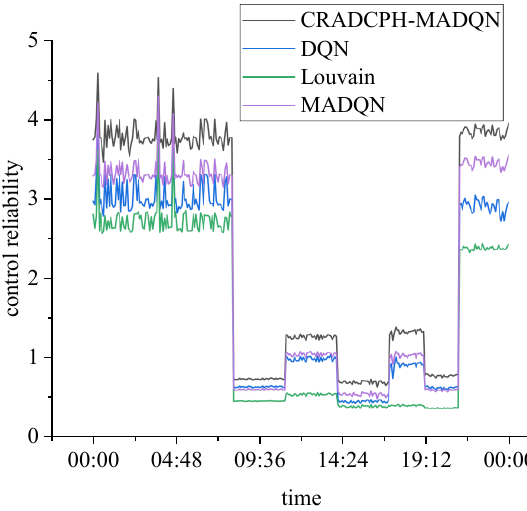
Figure 8. Root control